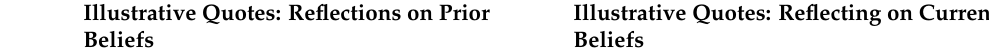
Table 4. Changes in beliefs regarding